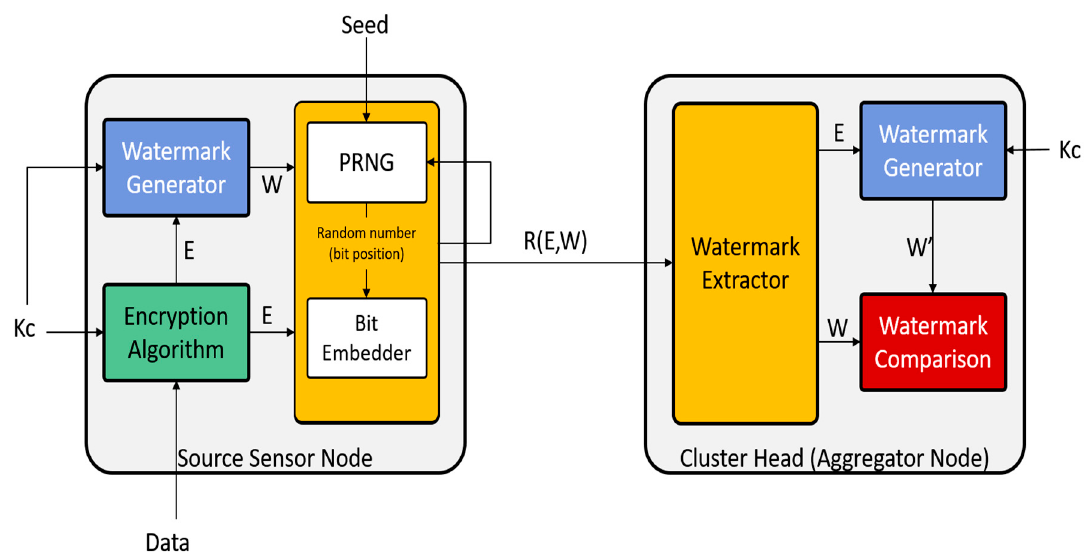
Figure 4. Watermark embedding.